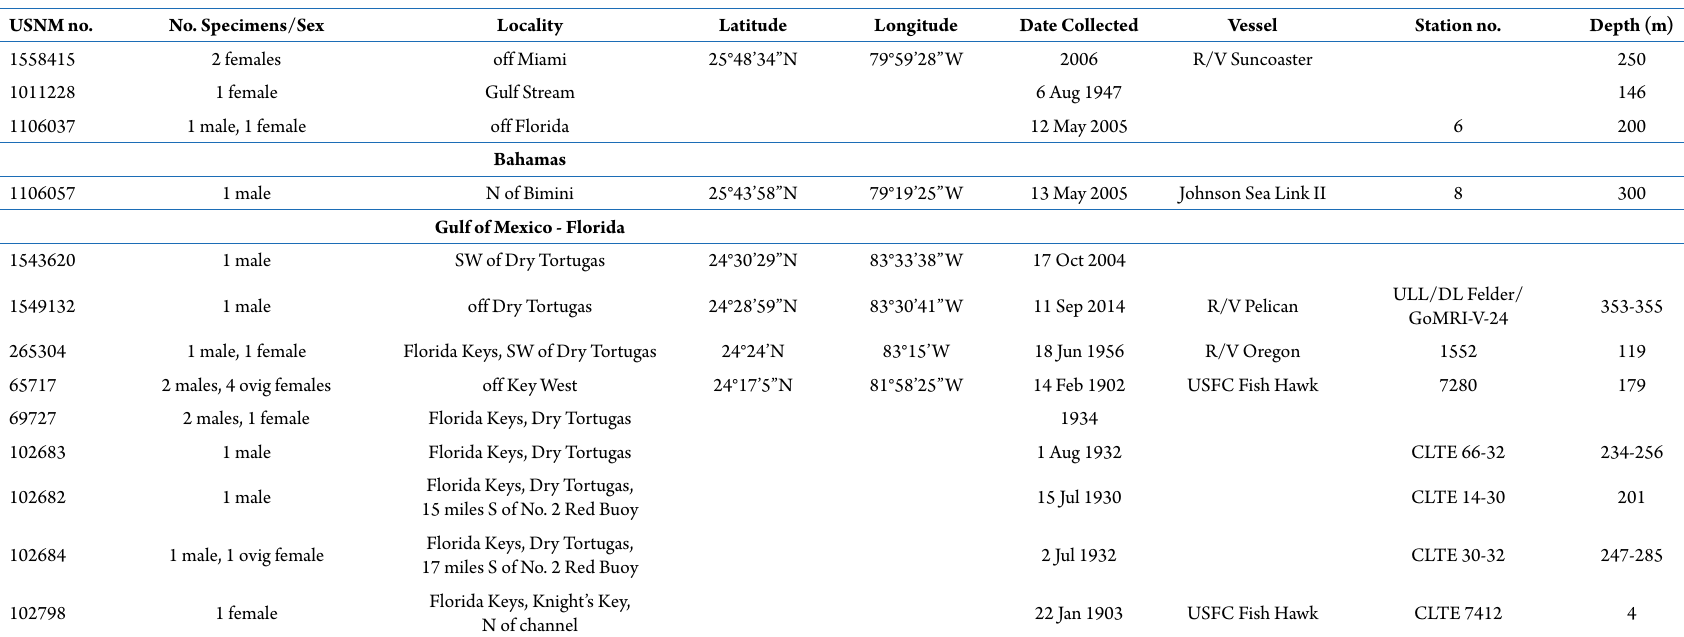
Table 1. Cont. USNM